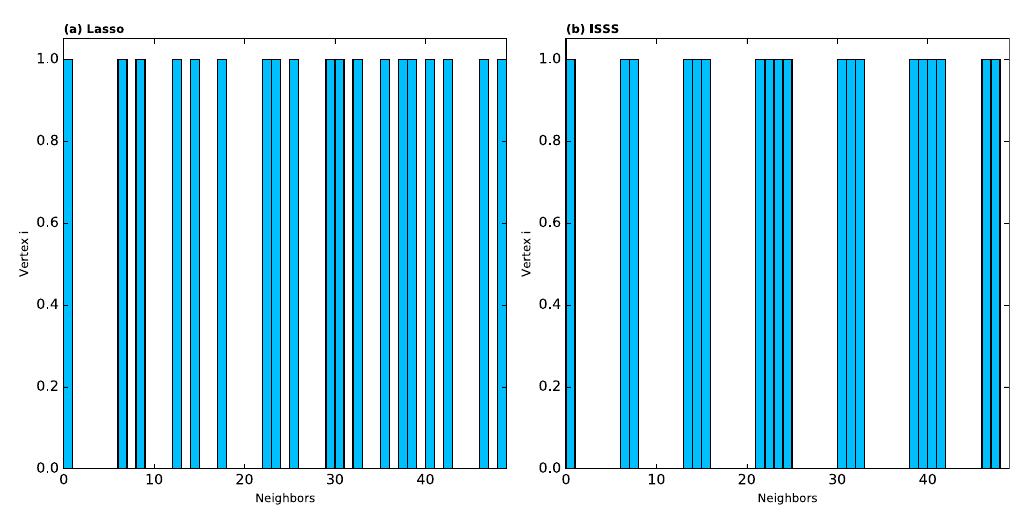
Figure 5. The clustering coefficient of the reconstructed network by ISSS and Lasso. The yellow line represents the real clustering coefficient of the network. The red line represents the clustering coefficient of the reconstructed network by ISSS.